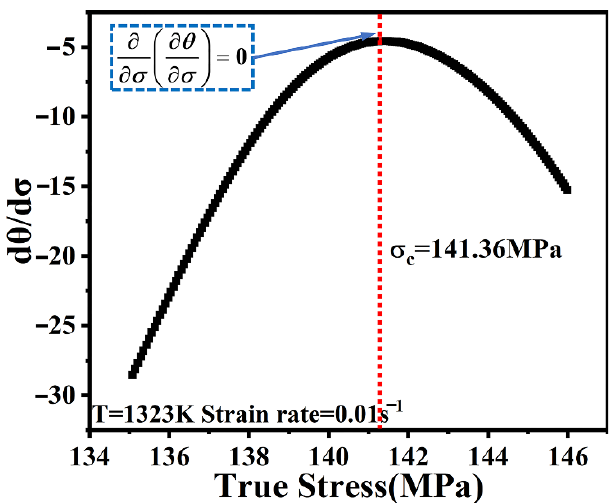
Figure 9. The relationship between work-hardening rate and the true stress.